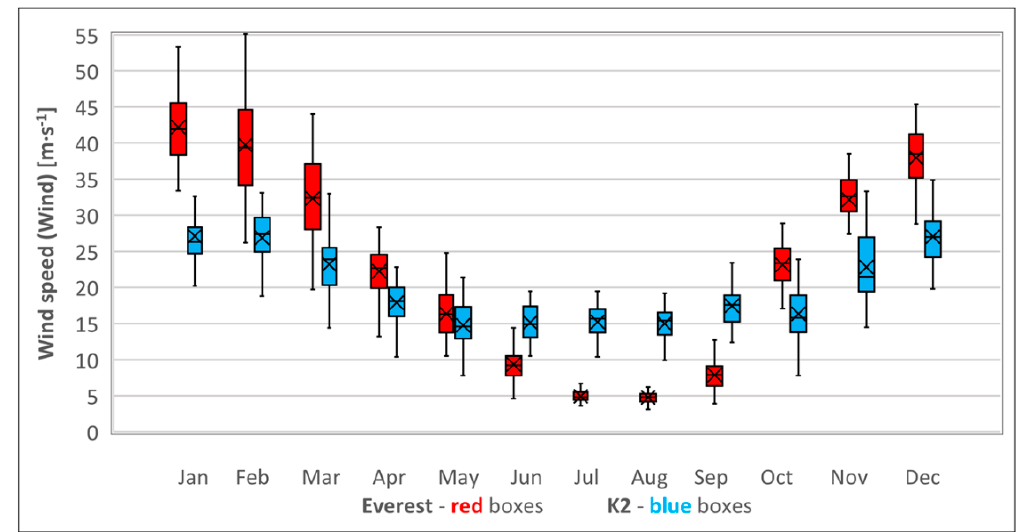
Figure 3. Annual cycle of wind speed (Wind) at the summits of Everest (red boxes) and K2 (blue boxes). Sample size—41 monthly means (1979–2019). Bars extend to the maximum and minimum BP, boxes span the 25th–75th percentiles, crosses inside the boxes mark the monthly mean, and vertical lines inside the boxes represent the monthly median.